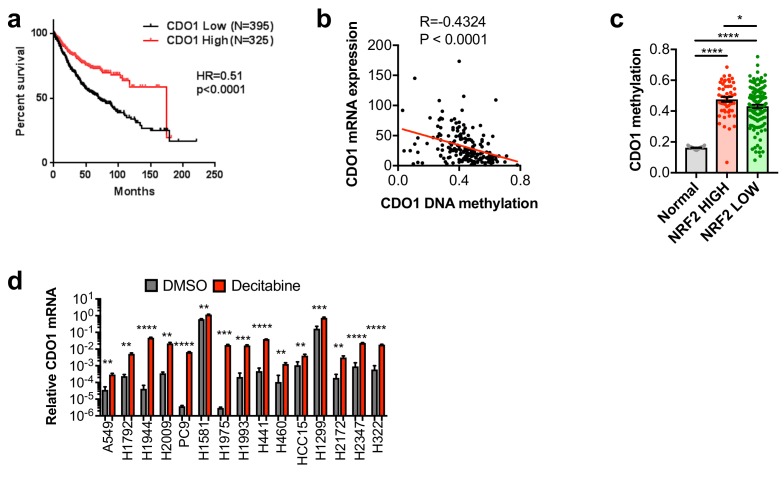
CDO1 is epigenetically silenced in NSCLC.(a) Association of CDO1 mRNA expression with NSCLC patient outcome. (b) Correlation between CDO1 promoter methylation and mRNA expression in lung adenocarcinoma patient samples from the TCGA. N = 185. (c) Methylation of the CDO1 promoter in samples from normal lung (Normal) or lung adenocarcinoma patient tumor samples based on NRF2 activity. Normal, N = 28. NRF2 high group = KEAP1 mutant patients + KEAP1 wild-type patients with NRF2 activity score >lowest KEAP1 mutant tumor (N = 51). NRF2 low group = KEAP1 wild-type patients with NRF2 activity score <lowest KEAP1 mutant tumor (N = 134). (d) Real-time PCR analysis of CDO1 mRNA expression following 5 uM decitabine treatment for 3 days with daily medium change. CDO1 expression was normalized to β-ACTIN expression, and relative expression compared to H1581 DMSO is shown. H1581 demonstrates high basal expression, in agreement with the western blot from Figure 3C. N = 3 replicates/group. Cells were treated with 0.25 µg/ml doxycycline for 2 days prior to and during the assay and fresh medium was added 4 hr prior to sample collection.10.7554/eLife.45572.011Figure 3—figure supplement 1—source data 1.CDO1 is epigenetically silenced in NSCLC.